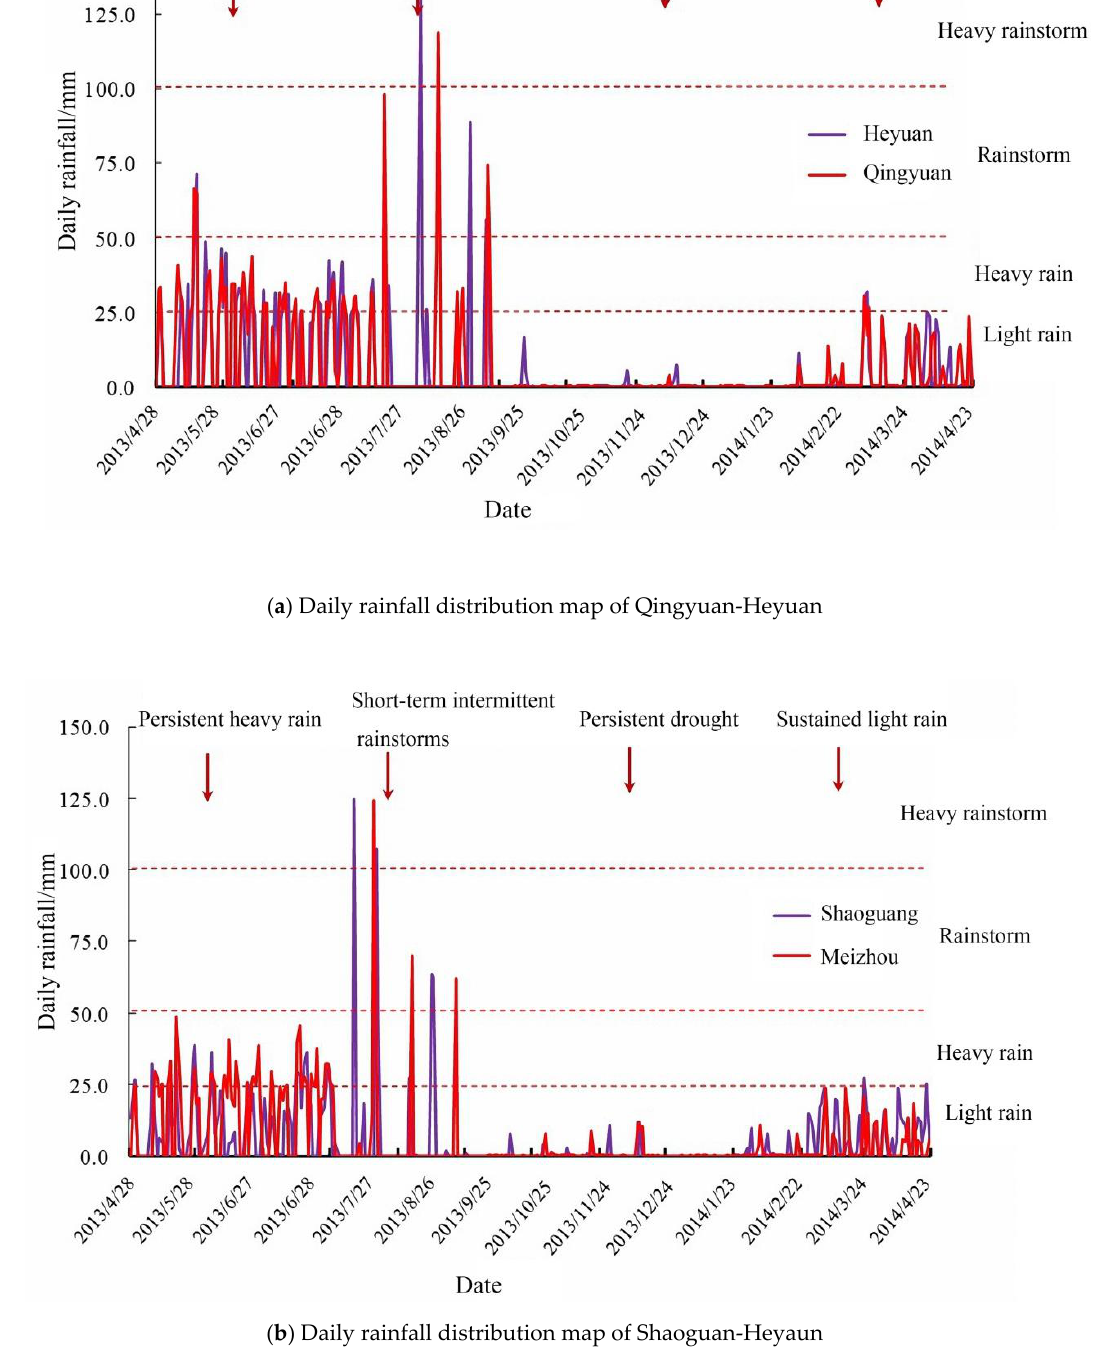
Figure 15. Rainfall in typical red-bed regions of Guangdong province.